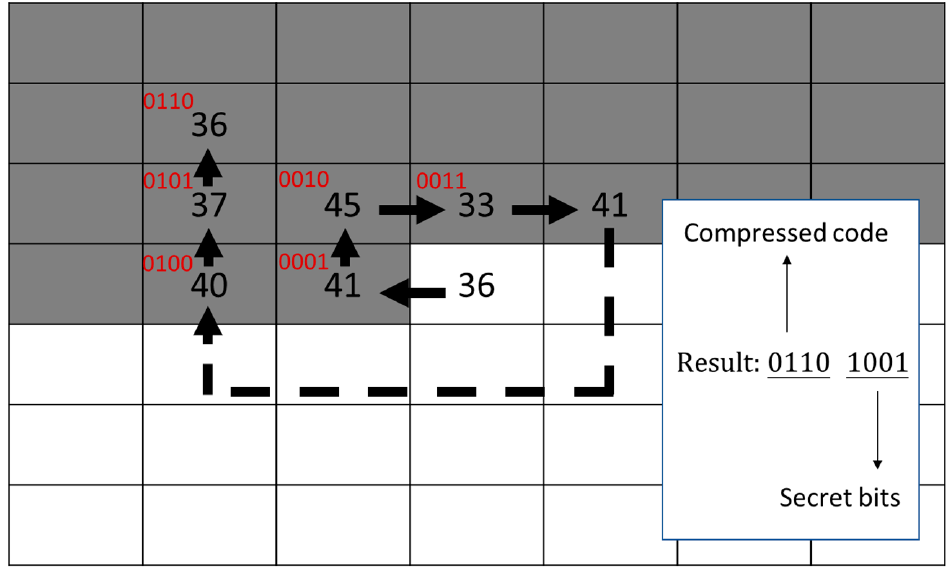
Figure 11. Embedding example 1: compressible index.